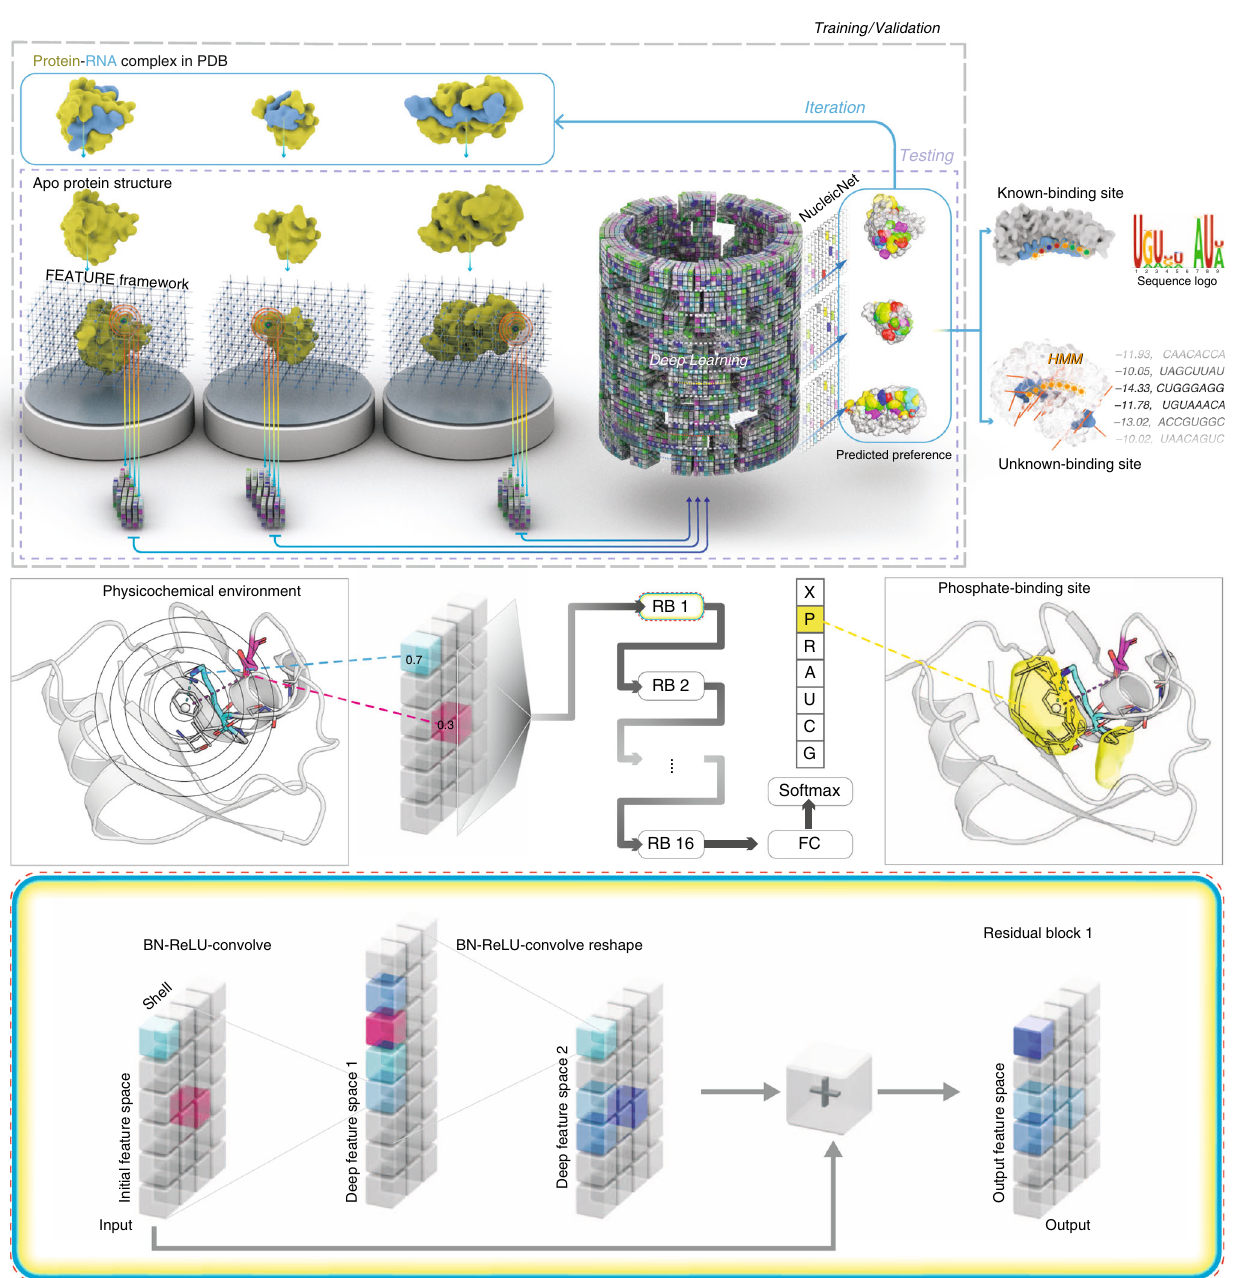
Fig. 1 Overview of NucleicNet. Top panel: training strategy and utilities of NucleicNet. Ribonucleoprotein structures in the PDB are stripped of their bound RNA. Grid points are placed on the surfaces of the proteins. Each of these grid points (locations) is analyzed by the FEATURE program for their surrounding physiochemical environment, which is encoded as a feature vector. Binding locations for all six classes of RNA constituents and non RNA-binding sites are labeled accordingly. The labels together with their respective vectors are compiled; this formulates the training input for a deep residual network. Parameters in the network are iteratively updated by backpropagation of errors and are trained to differentiate the seven classes. Once training is complete, the learned model can then be used to predict binding sites of RNA constituents for any query protein structure surface. Downstream applications of the prediction outcome includes production of logo diagrams for RBPs and a scoring interface for any query RNA sequence. Middle panel: physicochemical environment accession and introduction on the residual network. In the FEATURE vector framework, physicochemical environment is perceived by accounting properties on atoms of a protein within 7.5 Å of a grid point in a radial distribution setup. As such, space surrounding each grid point is divided into six concentric shells of spheres and, for each of these shells, 80 physicochemical properties (e.g., negative/positive charges, partial charges, atom types, residue types, secondary structure of the possessing residue, hydrophobicity, solvent accessibility, etc.) were accounted resulting in a tensor of dimension 6×80. The tensor is then transformed by a deep residual network with 16 sequential residual blocks. After that, the fi nal residual block is connected to a fully connected layer with a softmax operation to assess binding probability of each class on that location. Bottom panel: we illustrate the principle operations in a residual network, namely batch normalization (BN), recti fi ed linear unit (ReLU), locally connected network, and the quintessential skip connection, which adds the initial input back to the penultimate output